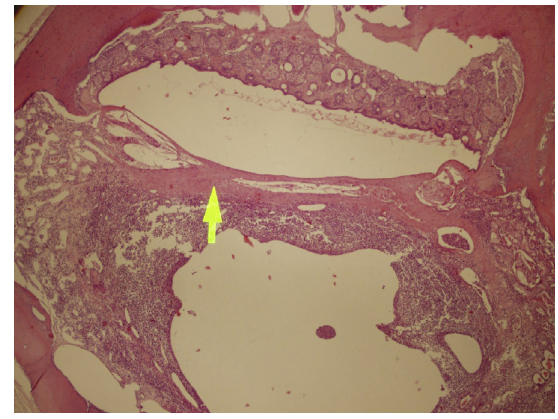
Mild tympanosclerosis (arrow) and mild otitis media (below the arrow) are demonstrated on a sample of melatonin group. H&E stain, 100 ×